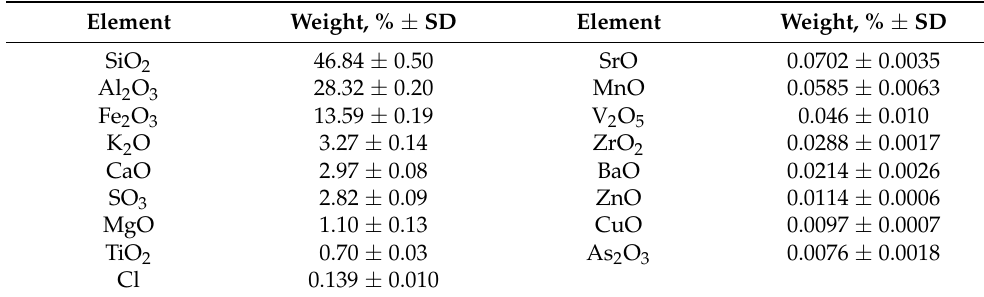
Table 2. XRF data of chemical compositions of NCQ1.